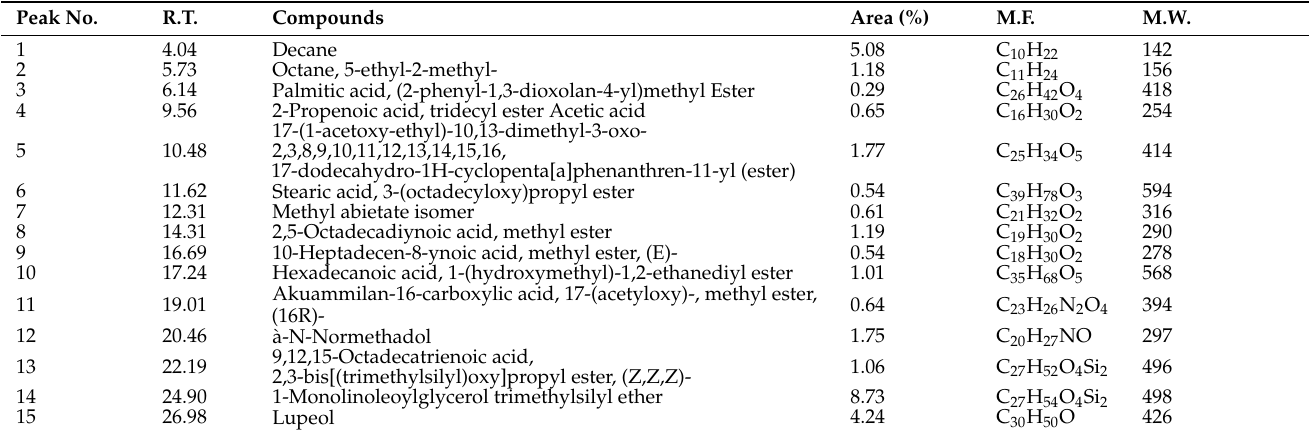
Table 8. Chemical composition of the methanolic extract of Rhazya stricta leaves and flowers. Peak